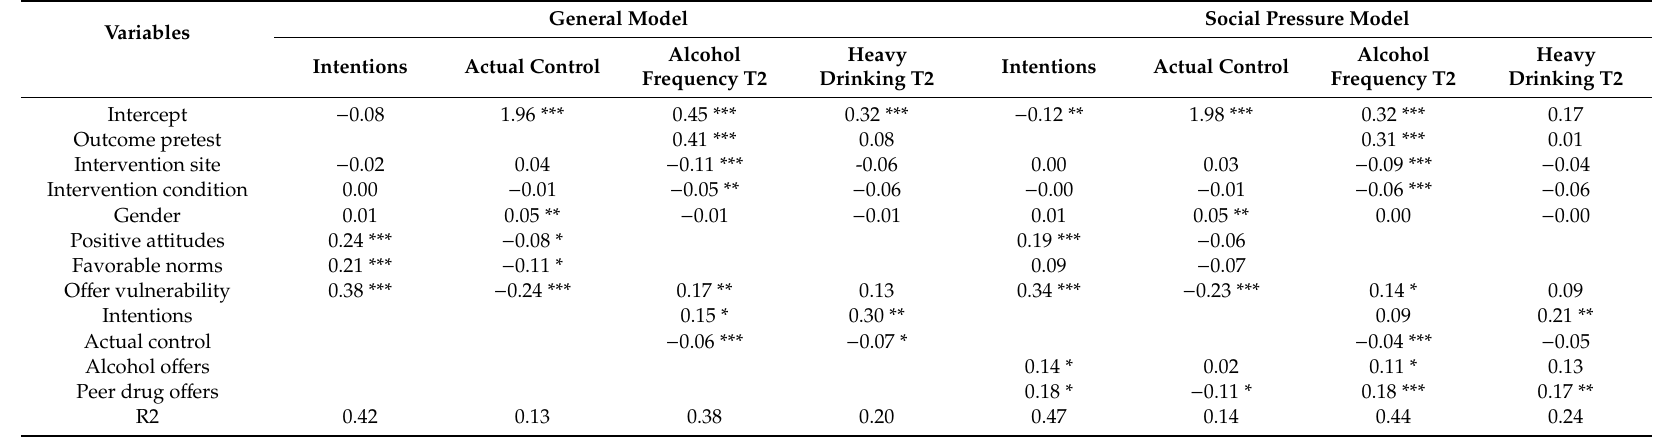
Table 3. Standardized Results of Path Analysis Models Predicting Alcohol Frequency and Heavy Drinking at